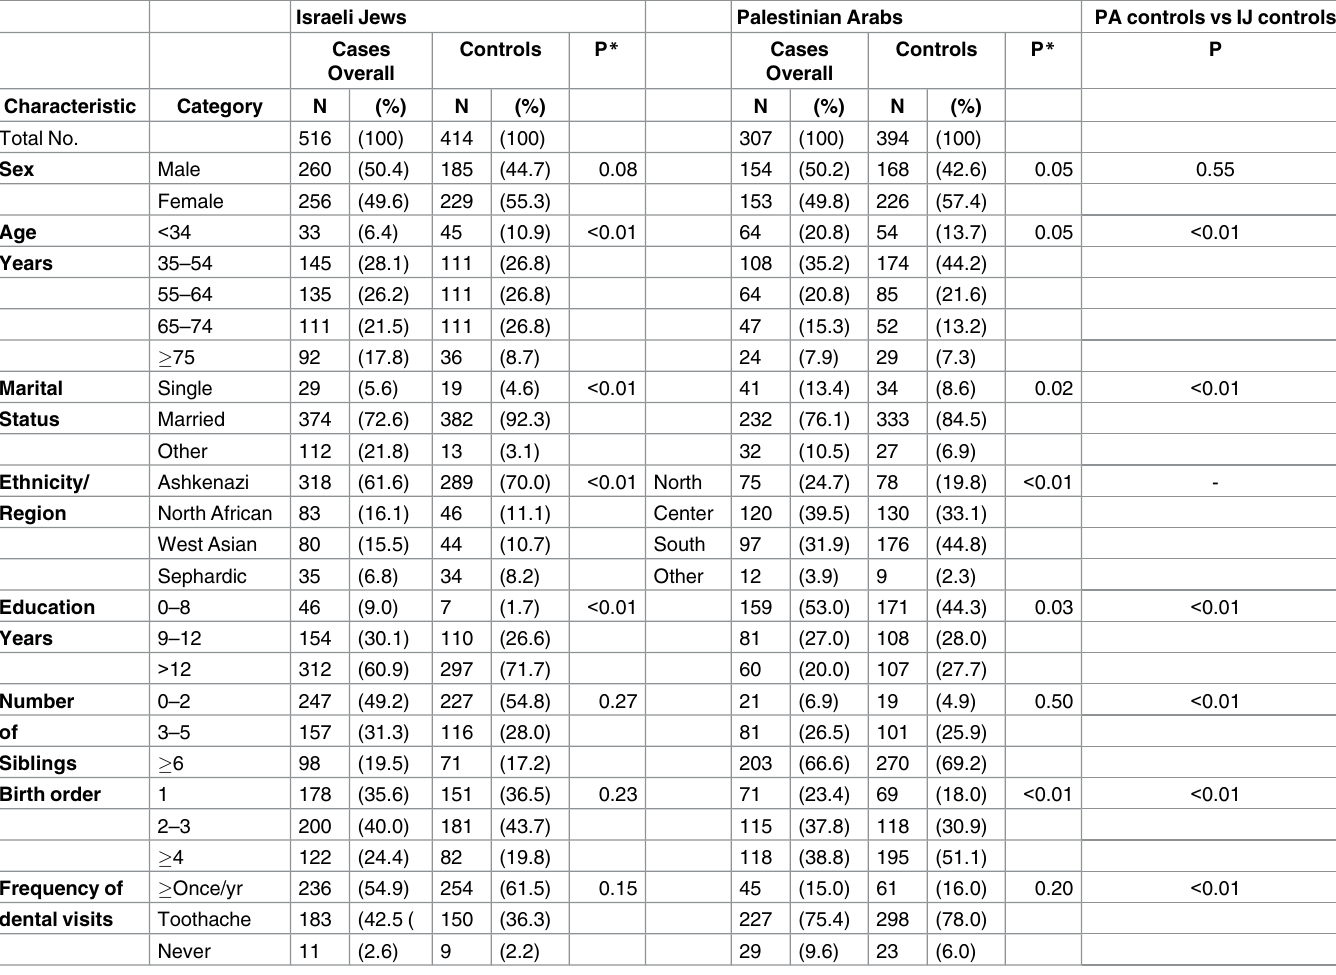
Table 1. Demographic characteristics for Israeli Jews and Palestinian Arabs by case-control status for overall B-cell non-Hodgkin